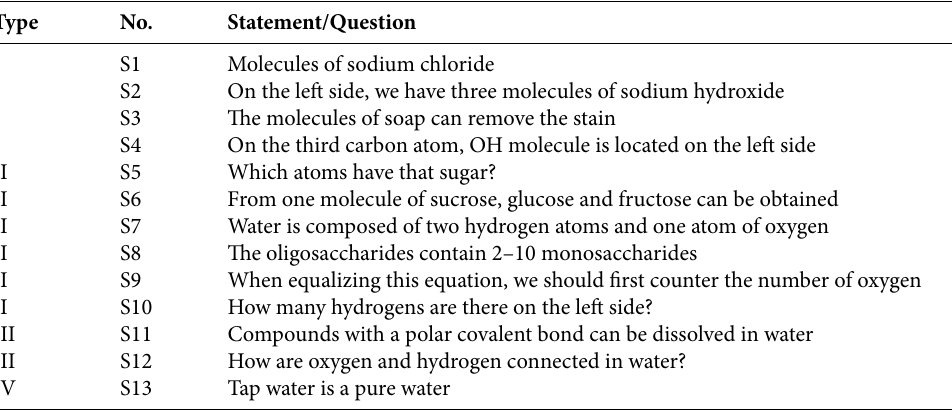
Table 2. List of Imprecise Statements in relation to Macro-Submicro Level Type No.